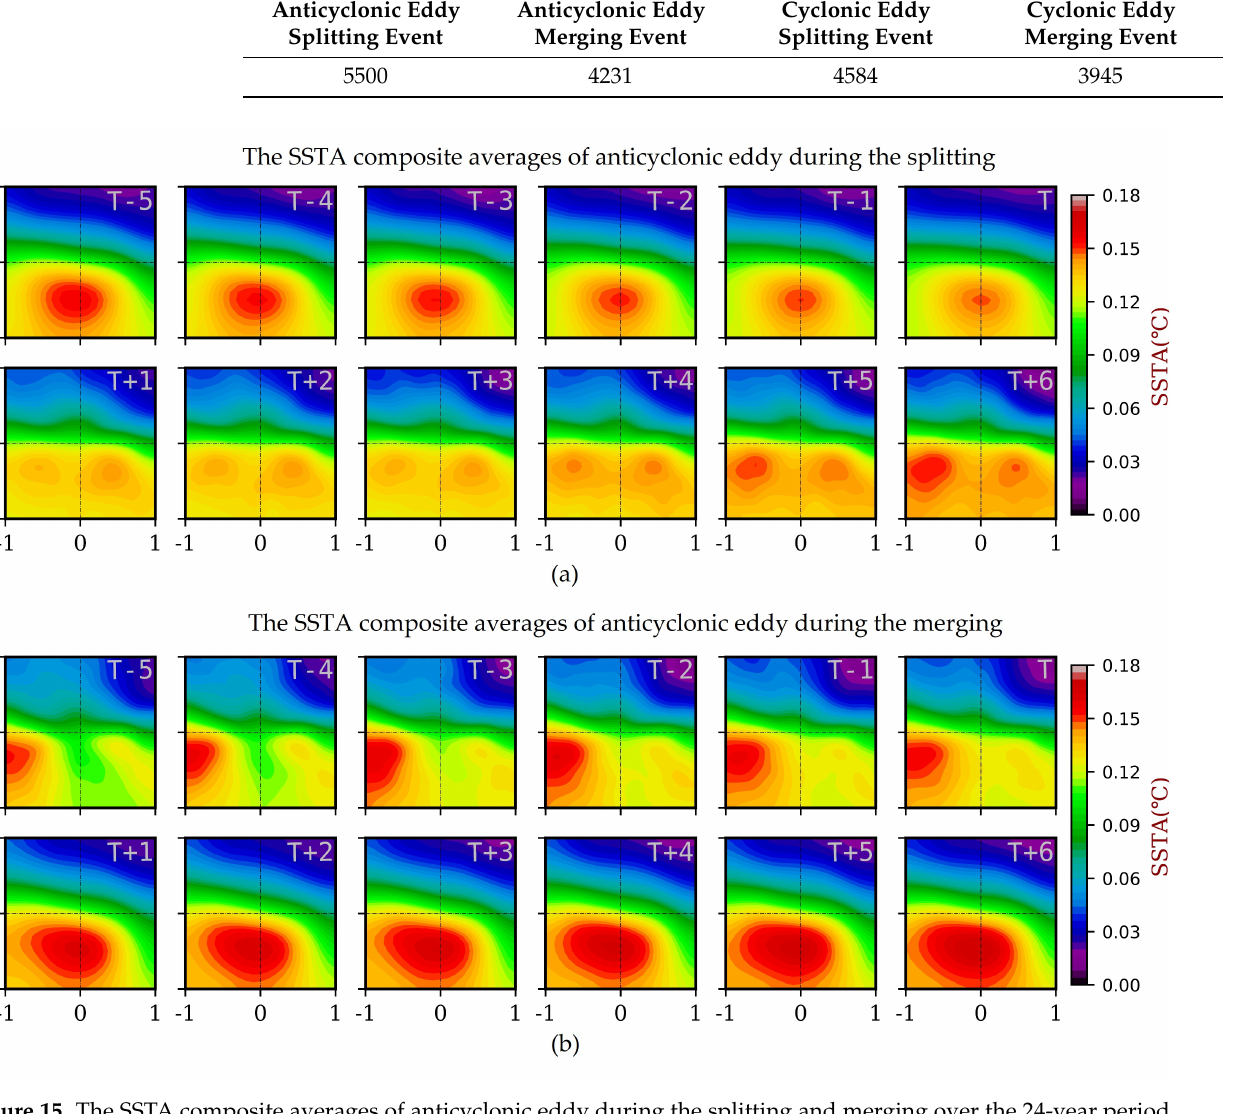
Figure 15. The SSTA composite averages of anticyclonic eddy during the splitting and merging over the 24-year period (January 1996–December 2019), where ( a , b ) represent eddy splitting process and eddy merging process, respectively. The top panel and the bottom panel represent the source branch and sink branch of the event, respectively, for both Figure 15a,b. Moreover, T is the day of splitting or